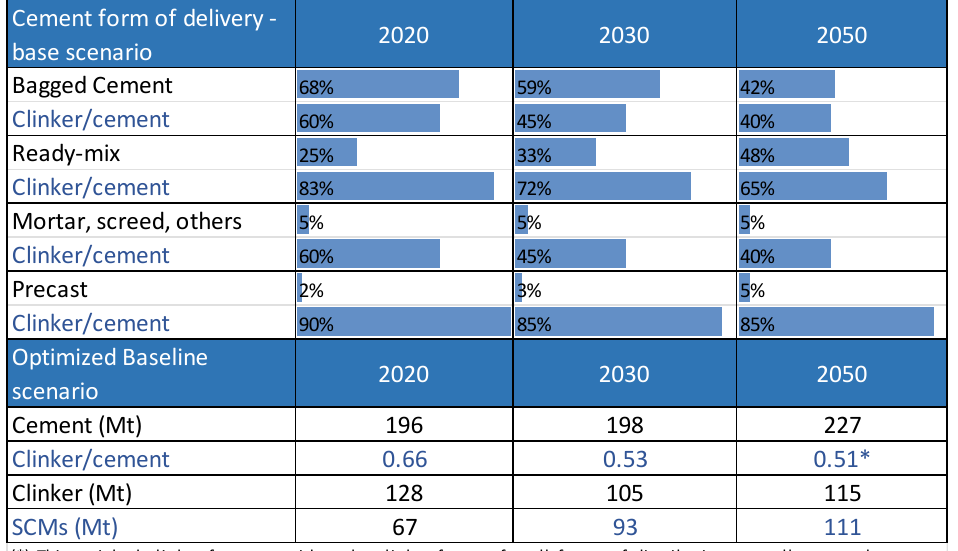
Table 2. Required reductions in clinker factor per form of delivery of cement in LAC and corresponding demands of clinker and